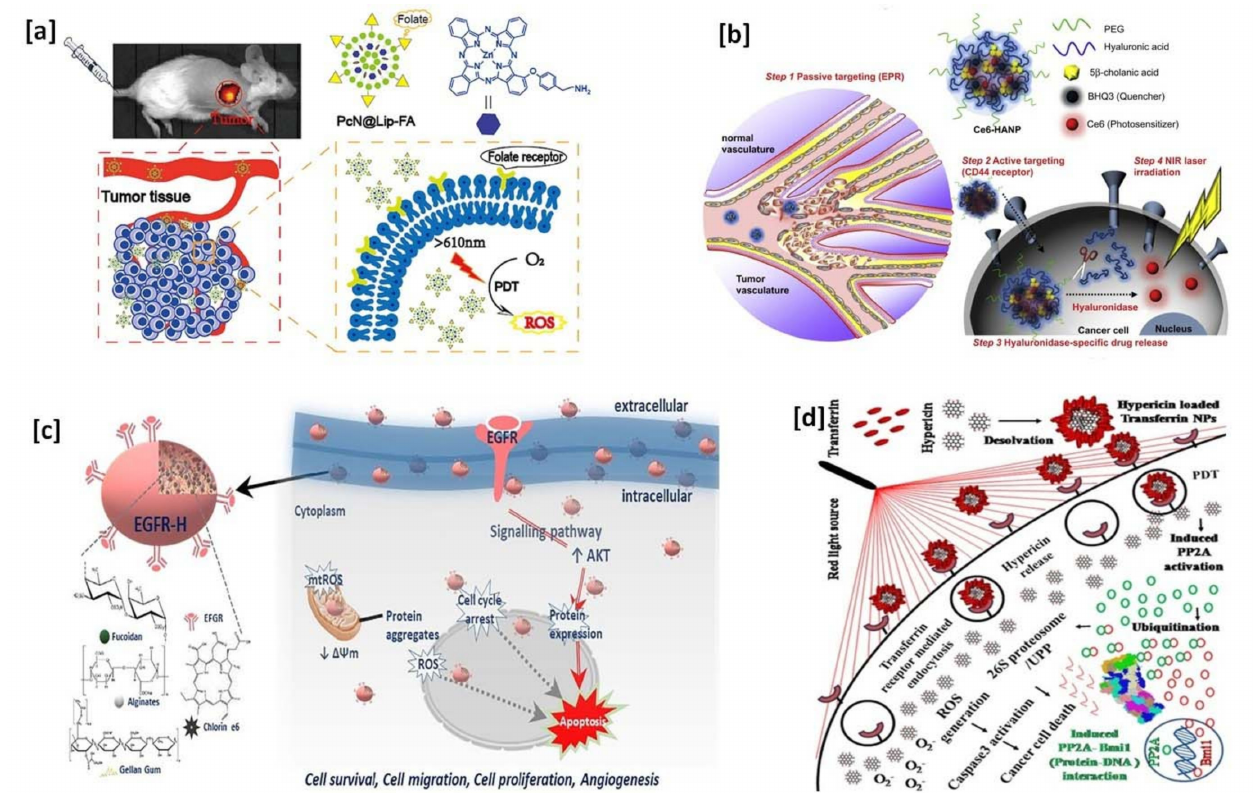
Figure 2. Schematic illustration of photosensitizers loaded cancer cell targeting efficiency of biocompatible nanocarriers